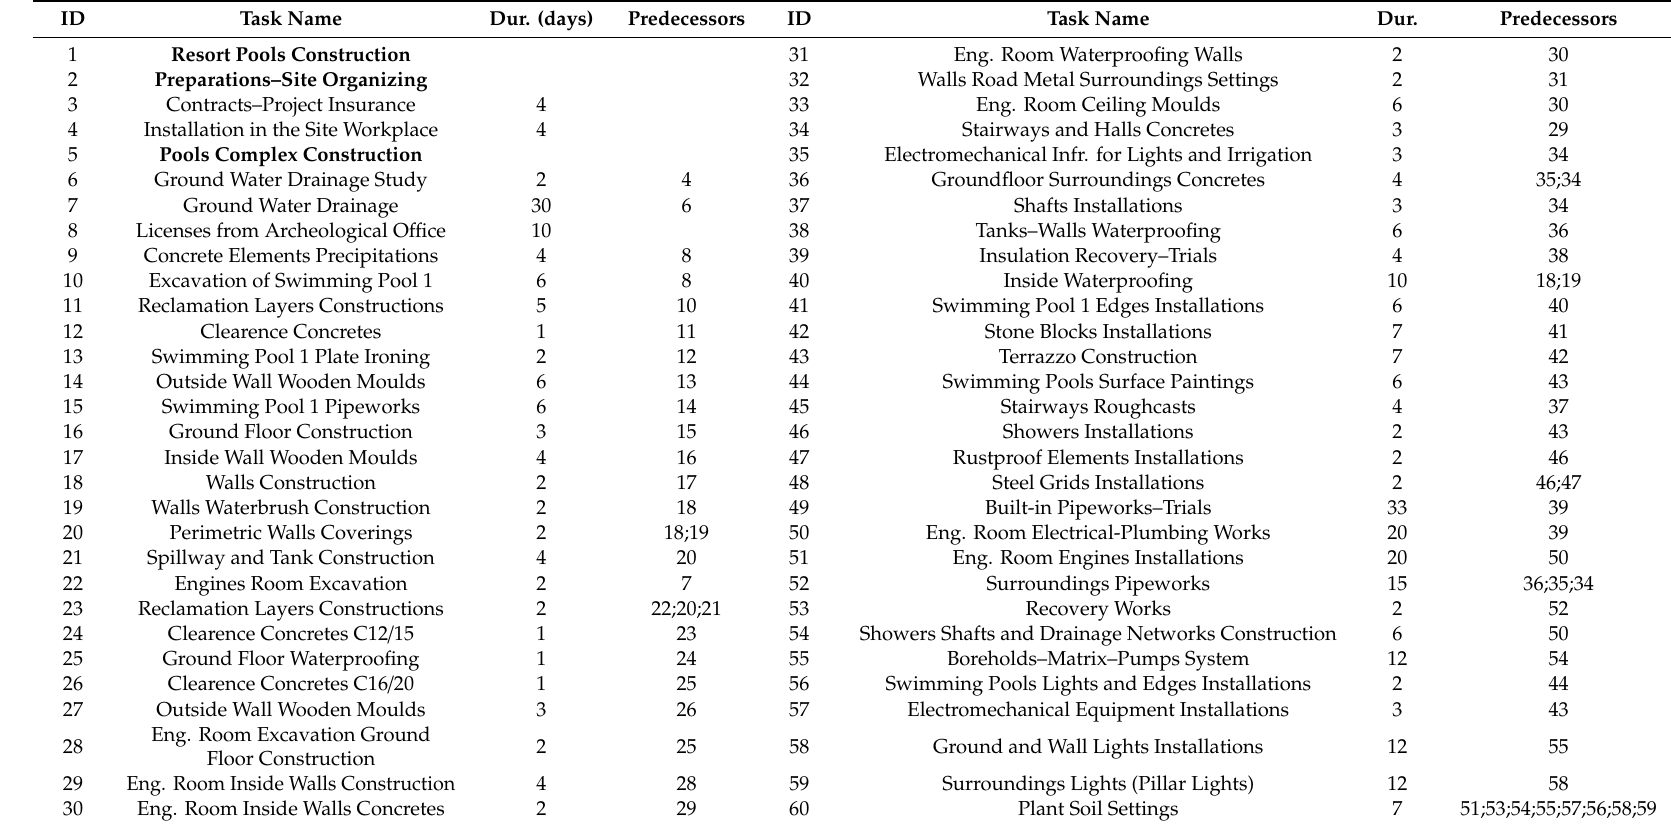
Table 1. The data of the case study